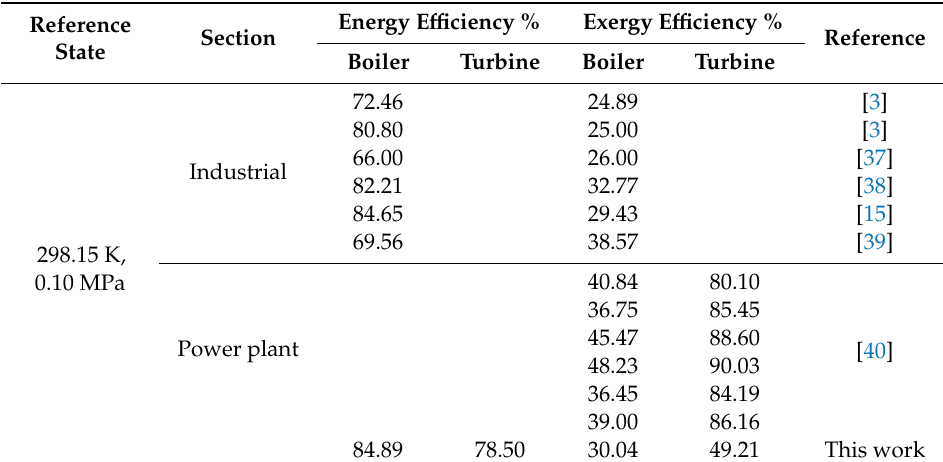
Table 3. Data for energy and exergy e ffi ciencies obtained from other